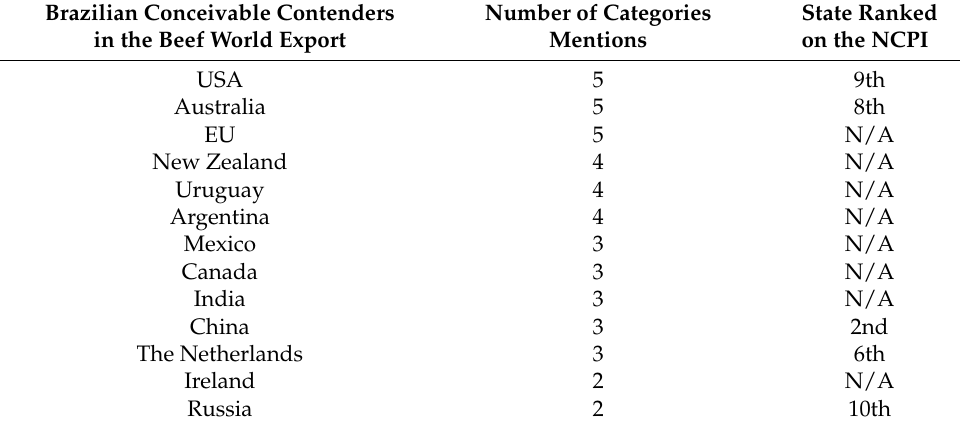
Table 5. Brazilian Beef Conceivable Contenders, Step 6 of the methodology (Section